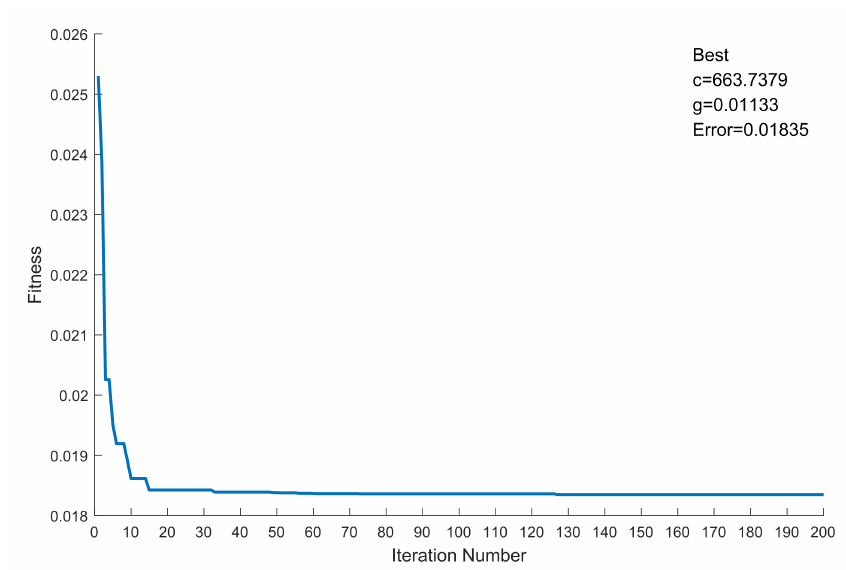
Figure 3. Hybrid kernel parameters